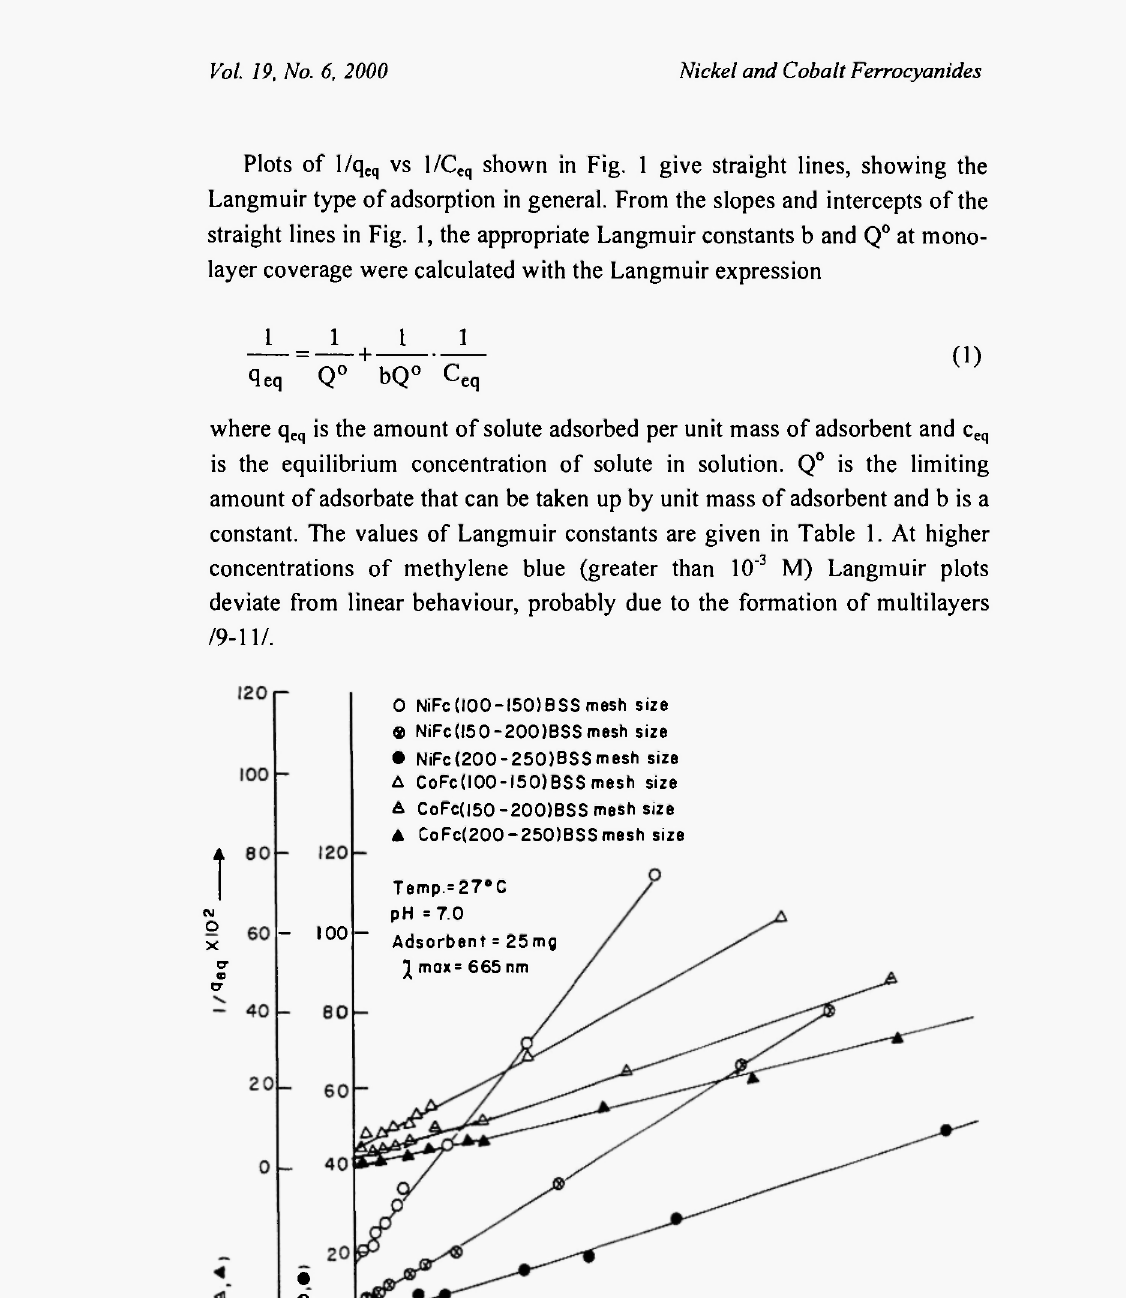
Fig. 1: Langmuir plots of methylene blue dye on different sieved fractions of nickel and cobalt